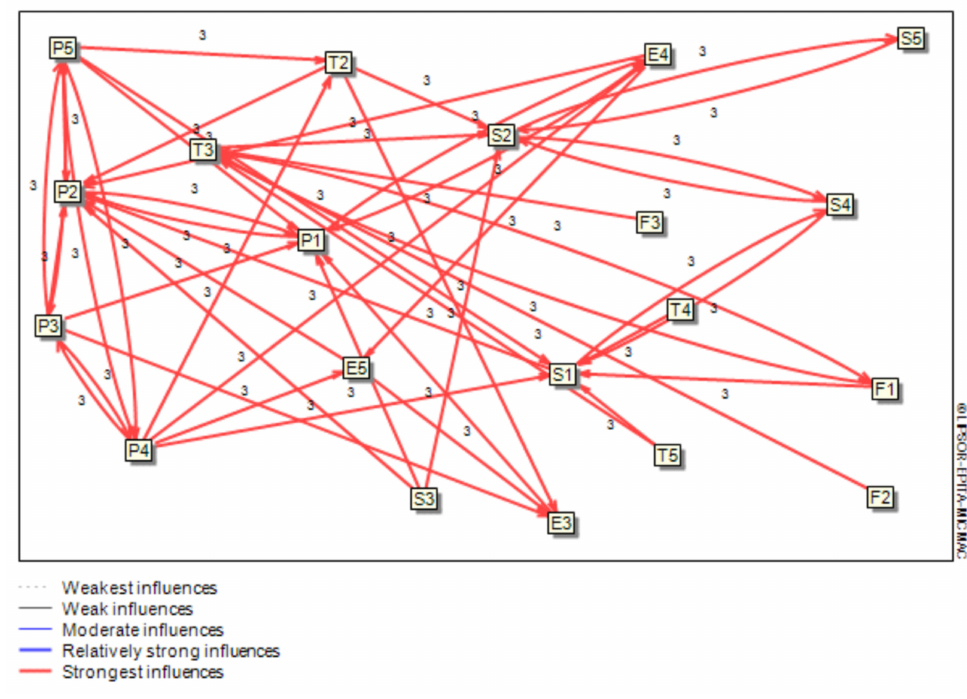
Figure 6. Direct influence graph of BSSs’ factors.